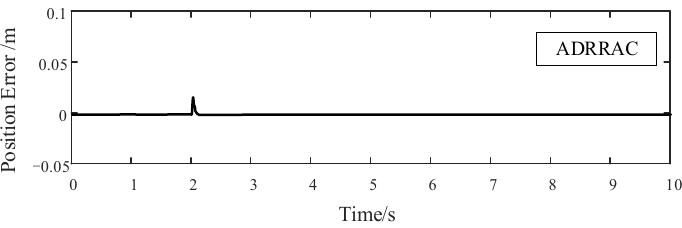
Figure 13. ADRRAC Tracking Error of 1 Hz Sinusoidal Signal with 700 N External Disturbance.